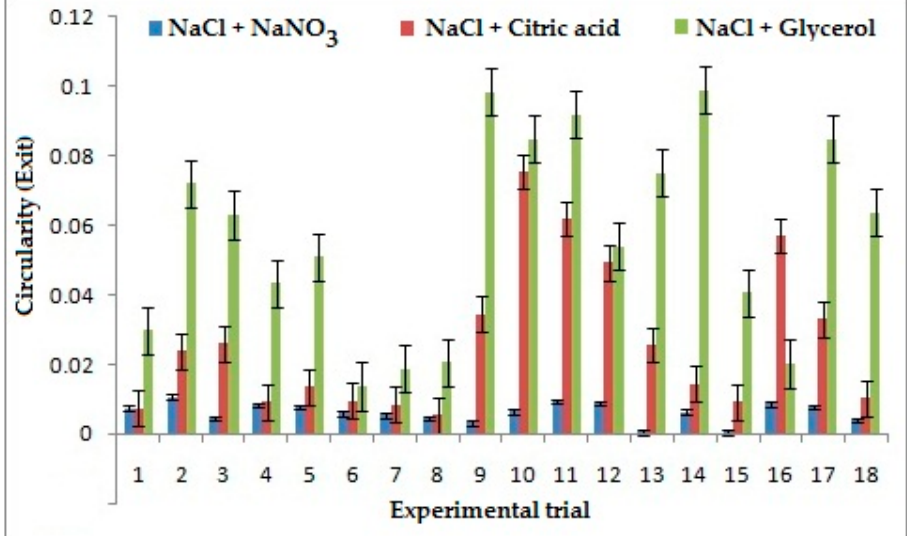
Figure 7. Effects of electrolytes and process parameters on circularity at exit.